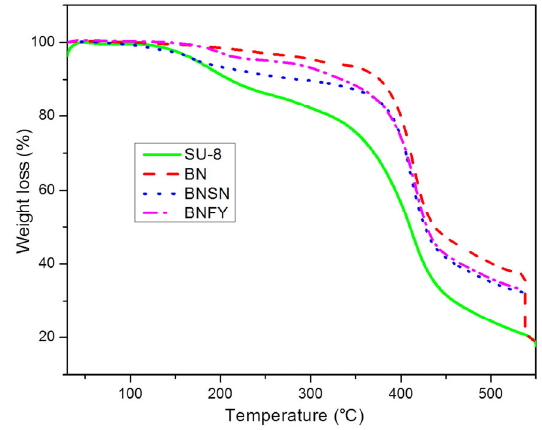
Fig. 4 Contact angle of the composite coating: (a) SU-8, (b) BN, (c) BNSN, and (d) BNFY.